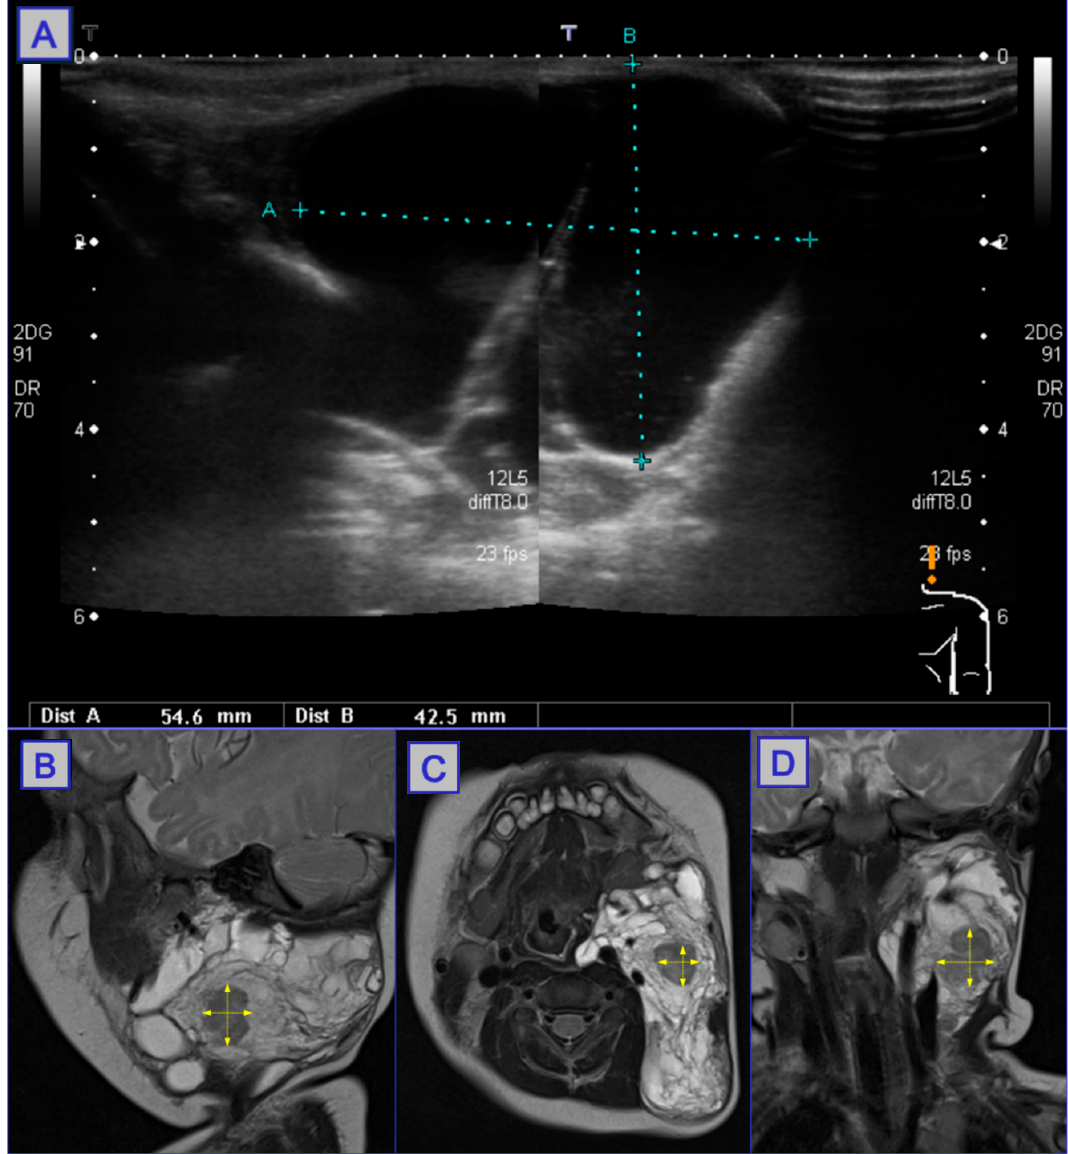
Figure 16. US imaging used to inspect the cystic hygroma ( A ), in which a large cystic lesion can be seen. MRI scanning ( B – D ) shows a considerable reduction in lesion size post-PDT. Reprinted with permission from ref. [88]. Copyright 2010 Photodiagnosis Photodyn. Ther.